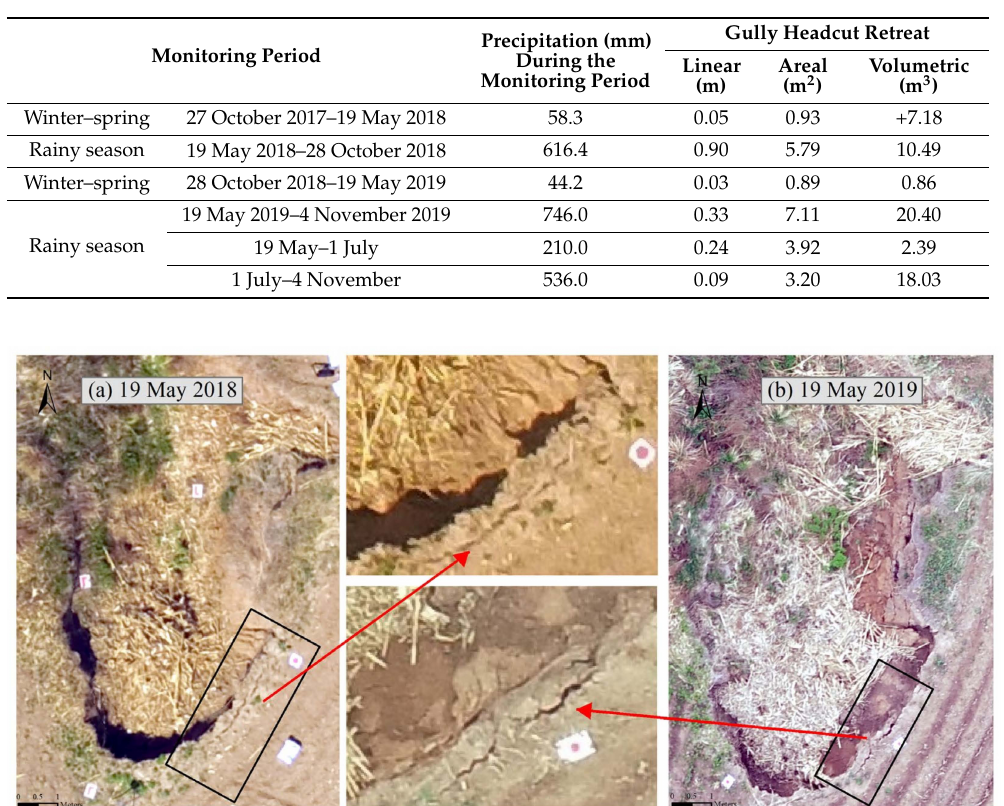
Figure 16. DoD map of the seasonal variations in the gully head (2017–2019). Table 5. Annual and seasonal variations in gully headcut retreat.